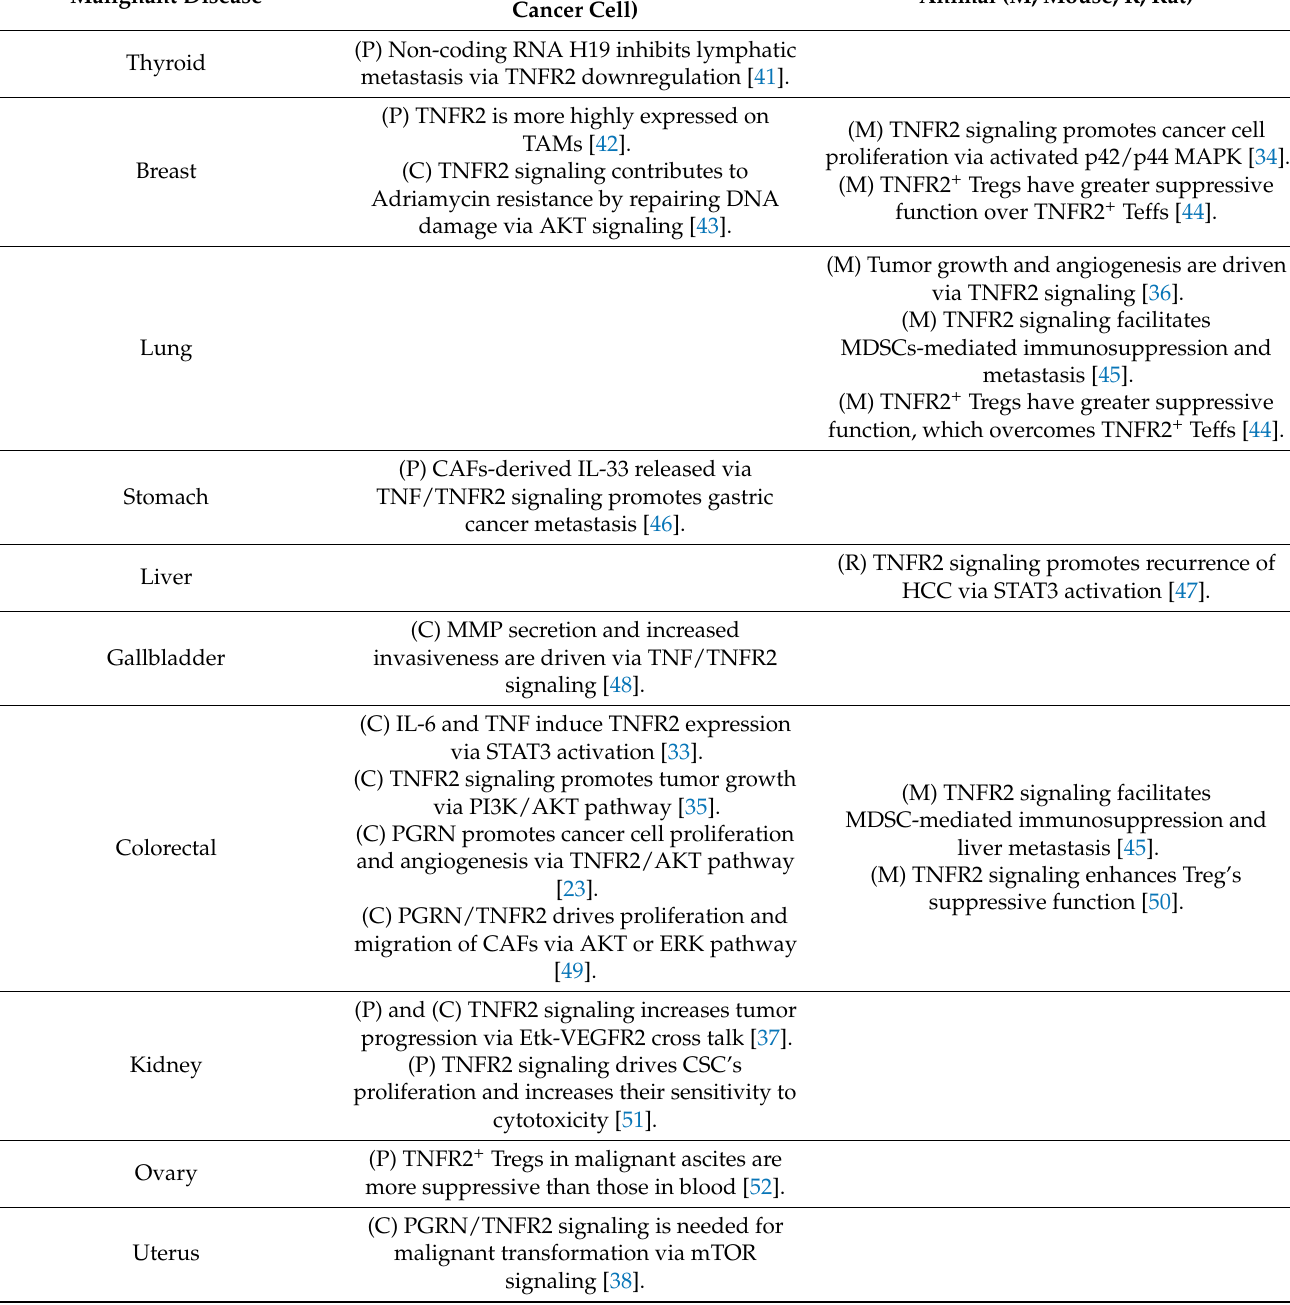
Table 1. Summary of TNFR2 Signaling-Related Mechanisms in the Tumor